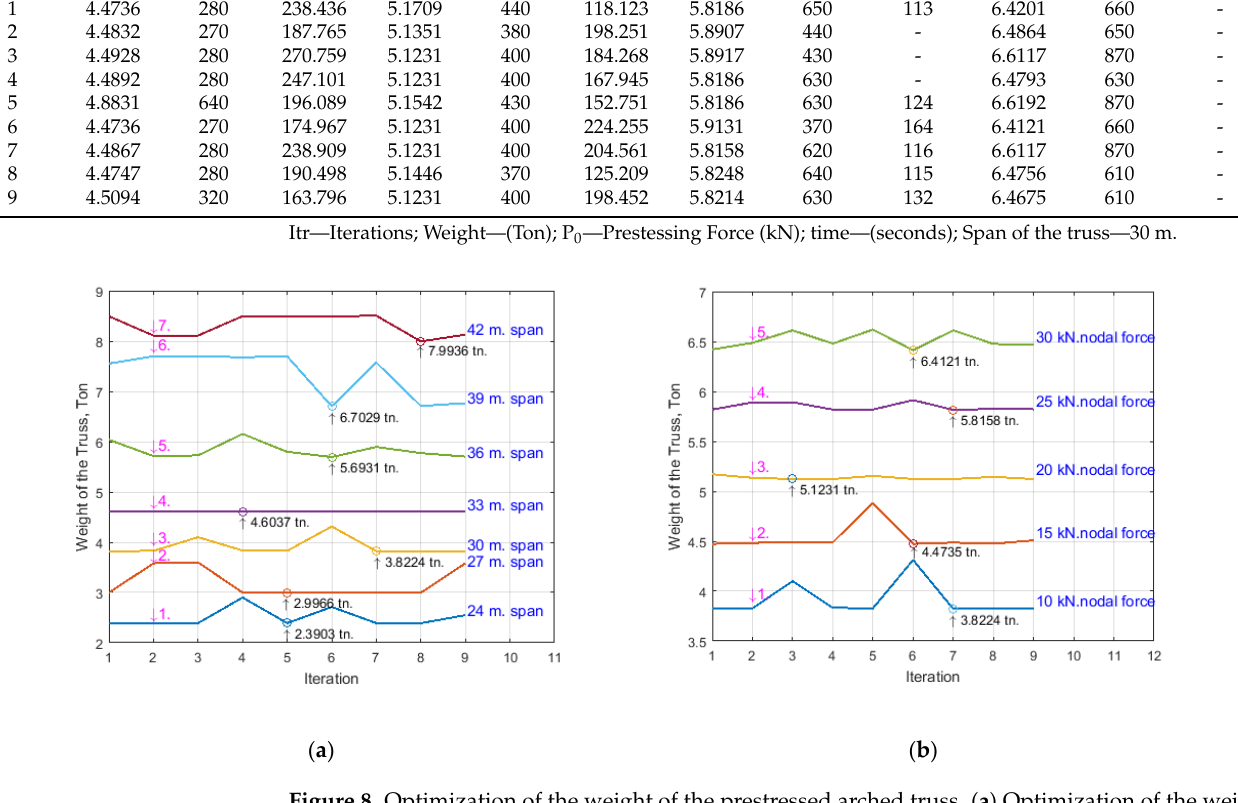
Table 6. Optimization results of the weights of the new truss at different nodal forces.